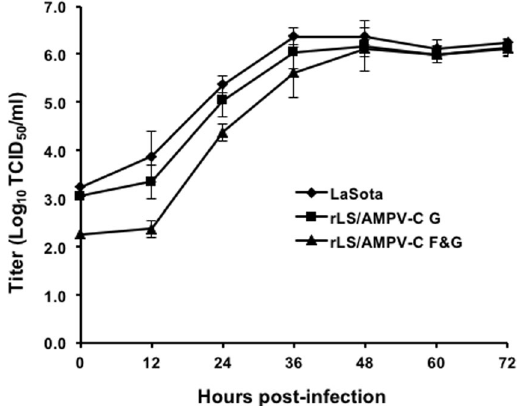
Figure 2. Growth dynamics of the recombinant viruses. DF-1 cells were infected with either rLS/AMPV-C F&G, rLS/AMPV-C G or LaSota strain at an MOI of 0.01. Every 12 h post-infection, virus was harvested by freeze-thaw cycles. Viral titers at each time point were determined by TCID 50 titration in DF-1 cells, in triplicates. The mean titer at each time point is expressed in log 10 TCID 50